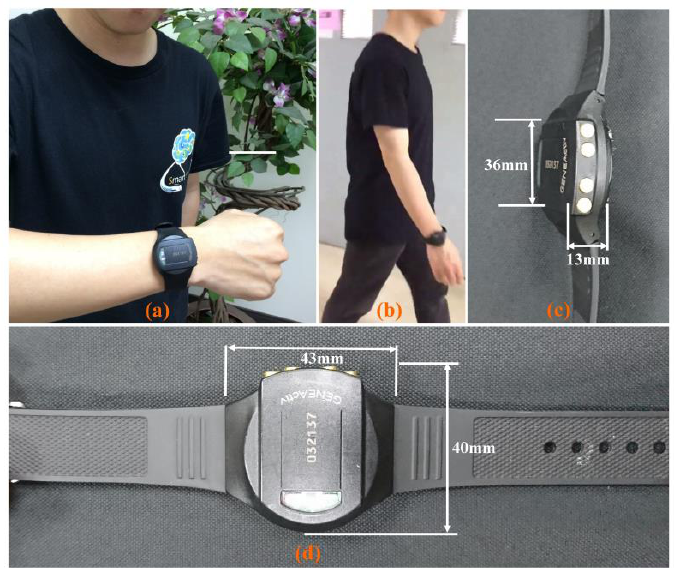
Figure 1. ( a ) Accelerometer-based GENEActiv device, Activinsights Ltd., Huntingdon, UK. ( b ) Walking subject with GENEActiv device on right-wrist. ( c ) Physical dimensions and side view of the GENEActiv device. ( d ) Top view of the device.